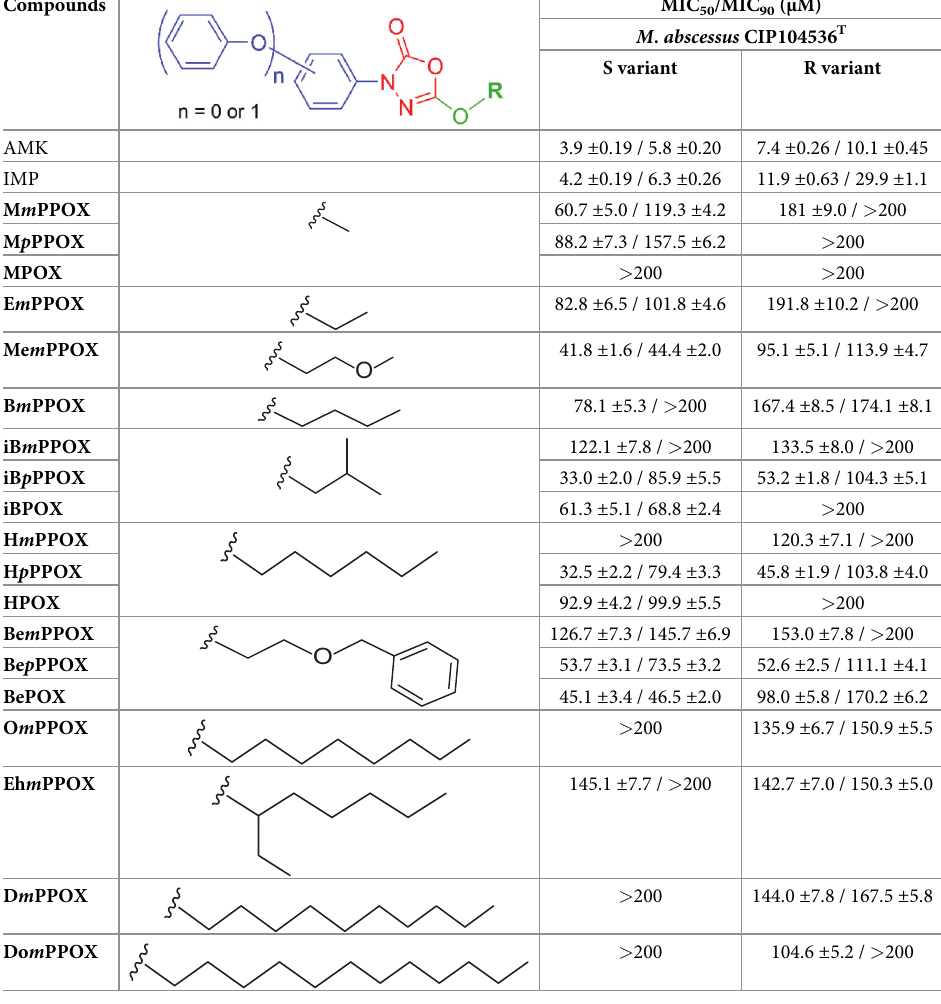
(Table 1). In all other cases, MIC Table 1. Antibacterial activities of the oxadiazolone derivatives against M . abscessus growth in broth medium using the REMA method a .